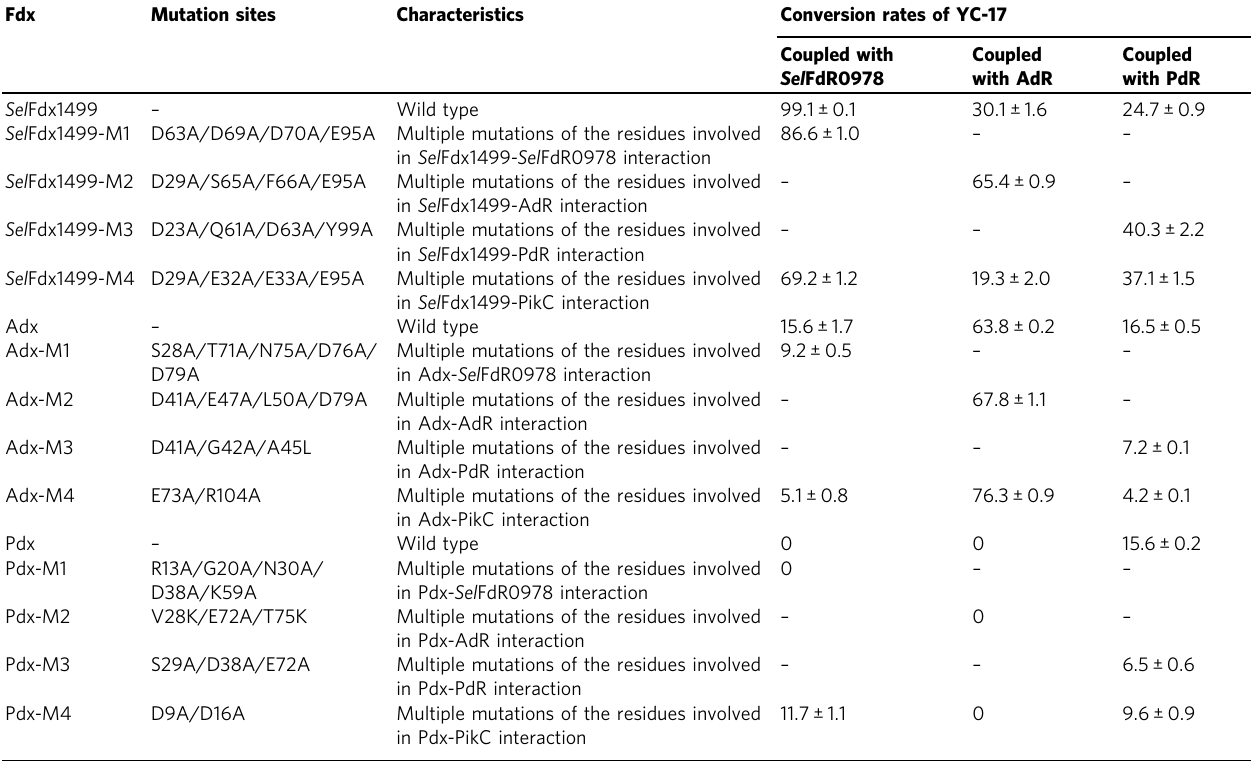
Table 2 Conversions of YC-17 by PikC when Fdx mutants coupled with different FdRs a . Fdx Mutation sites